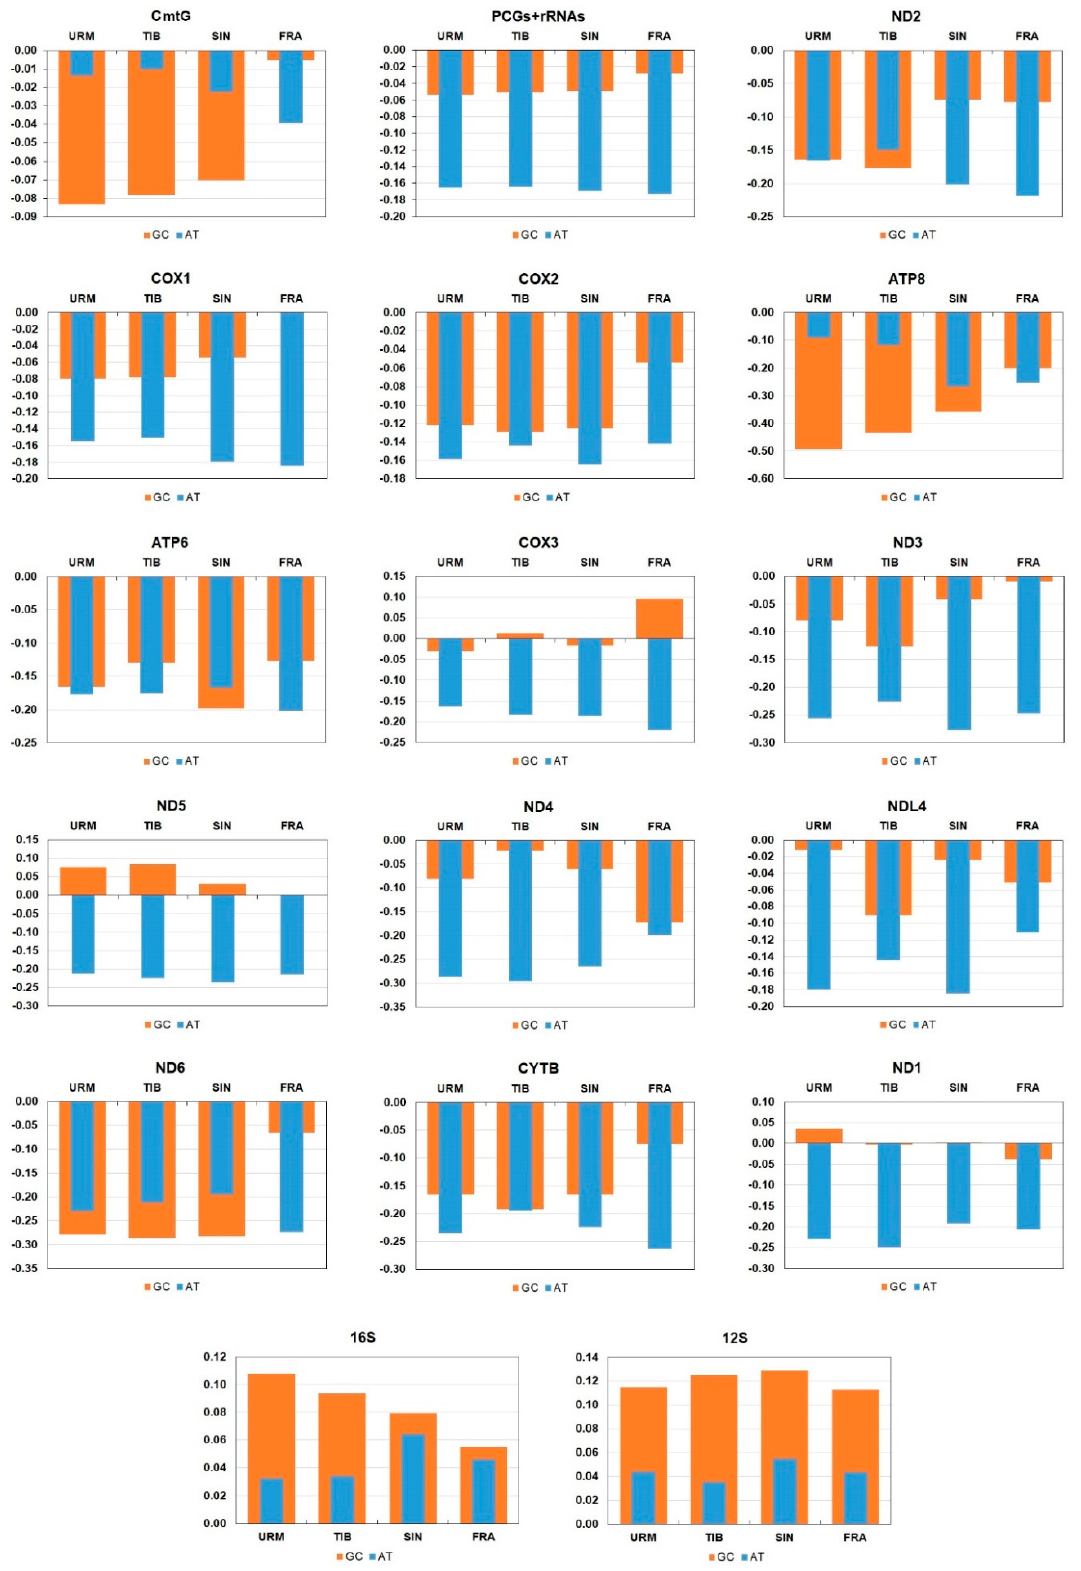
Figure 2. AT- and GC-skews of the complete mitochondrial genome, protein-coding, ribosomal RNA genes in the mitochondrial genome of A. urmiana and three related species in genus Artemia (URM: this study; TIB: JQ975177; SIN: MK069595; FRA: X69067). URM: A. urmiana , TIB: A. tibetiana , SIN: A. sinica , FRA: A. franciscana.